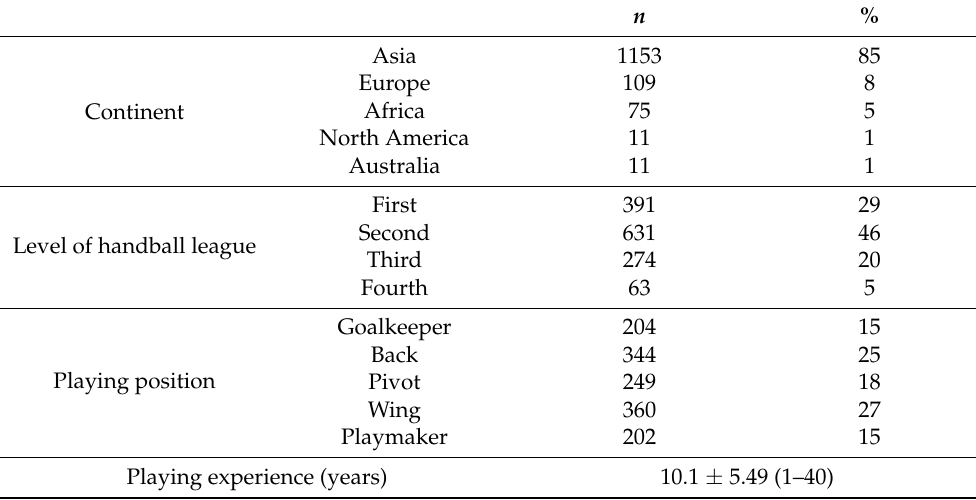
Table 1. Description of the sample ( n = 1359) regarding origin and handball activity.